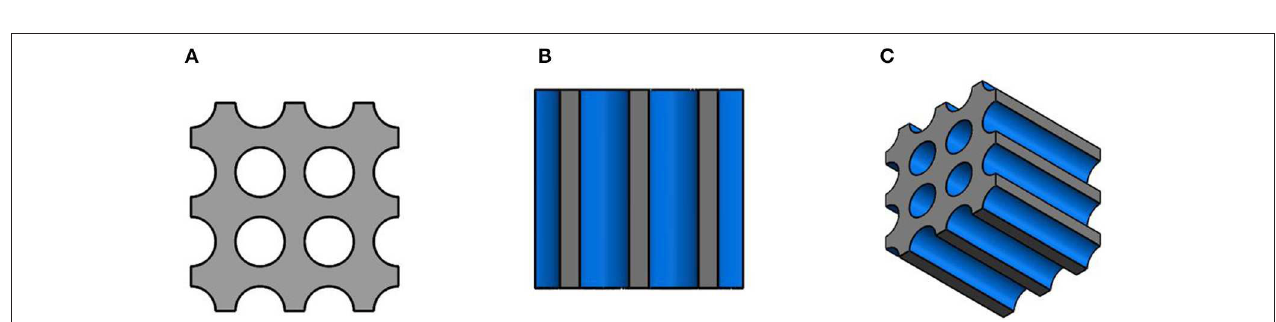
FIGURE 3 | (A) A differential volume of the zoomed-in top/bottom view of the AMR with the cylindrical micro-channel matrix. (B) A differential volume of a zoomed-in side view of AMR with the cylindrical micro-channel matrix. (C) A differential volume of a zoomed-in isometric view of AMR with the cylindrical micro-channel matrix. The solid material is displayed gray and the flow channels are displayed in